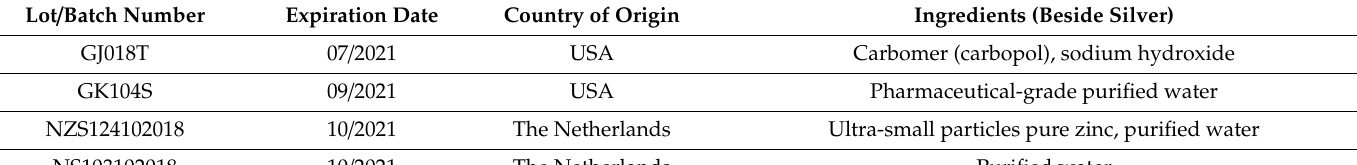
Table 2. Label information of the 14 di ff erent silver products (part